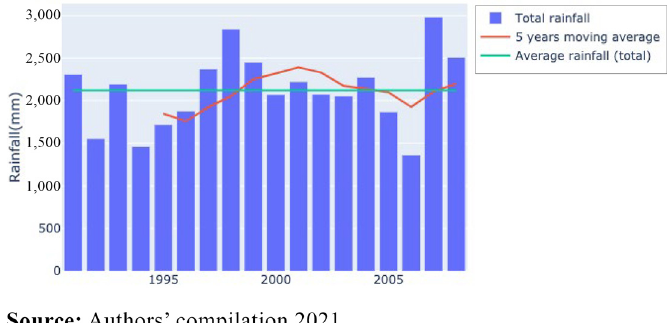
Figure 2. Annual departure